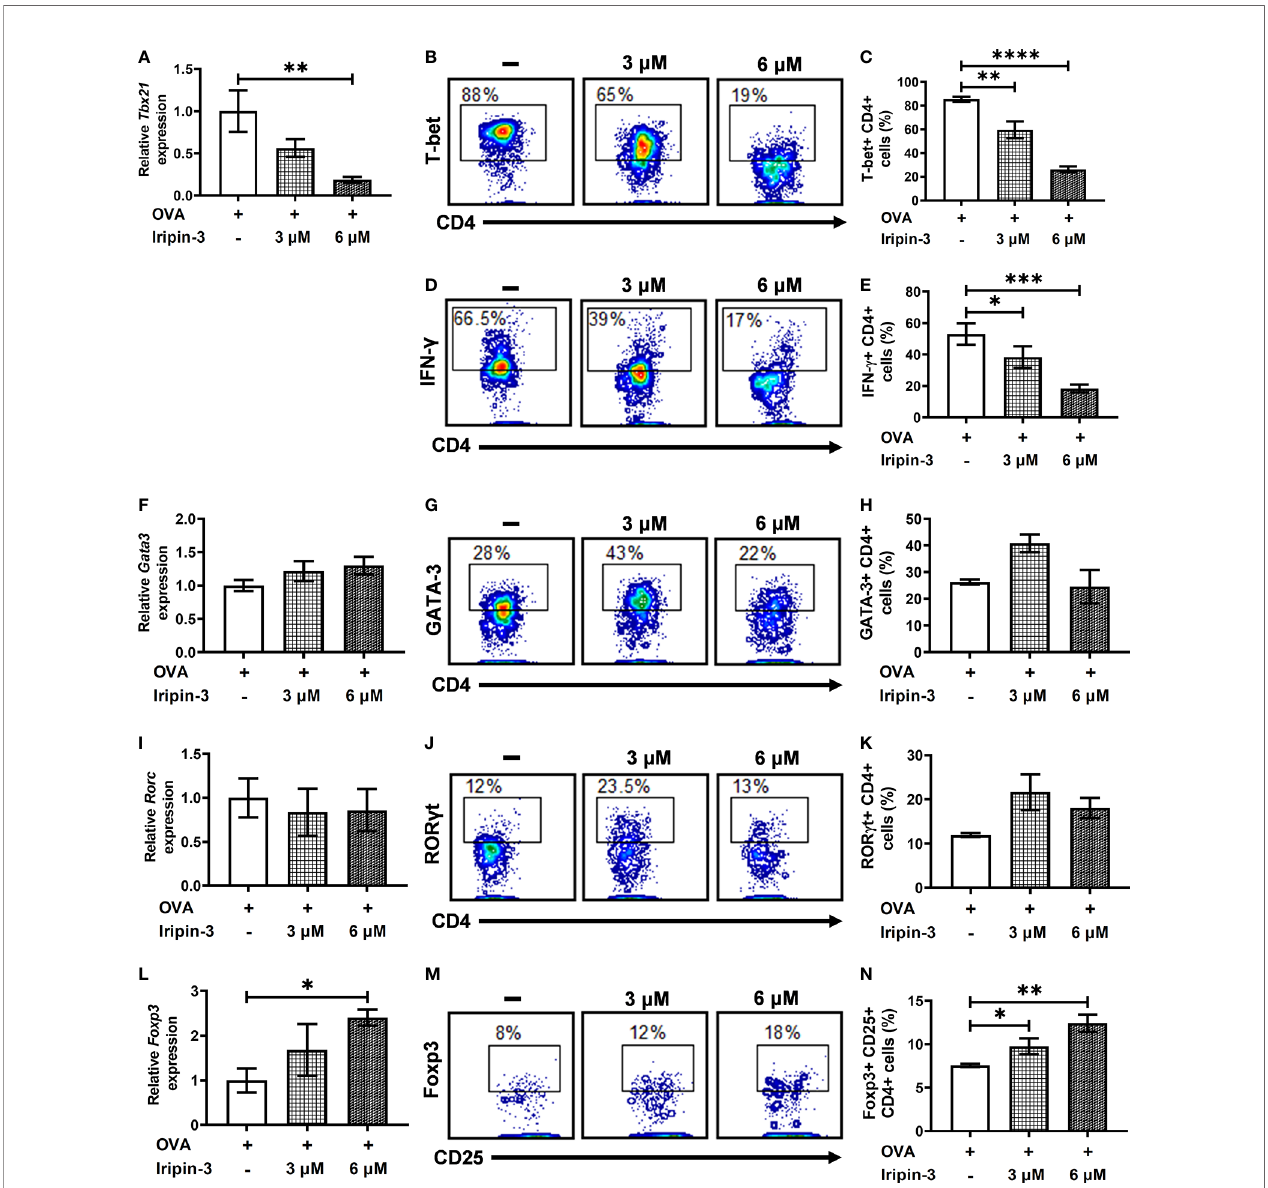
FIGURE 10 | Iripin-3 alters the expression of CD4 + T cell transcription factors at both the mRNA and protein levels. (A, F, I, L) Expression of Tbx21 (A) , Gata3 (F) , Rorc (I) , and Foxp3 (L) in CD4 + cells stimulated with OVA peptide for 72 h. Cells were untreated with Iripin-3 or were treated with 3 m M or 6 m M Iripin-3. Cells incubated only in the presence of OVA peptide were utilized as a calibrator during calculations of relative expression values. Data are presented as mean ± SEM of four independent experiments (* p < 0.05, ** p < 0.01). (B, D, G, J, M) Representative contour plots showing the proportion of OVA peptide-stimulated CD4 + splenocytes expressing T-bet (B) , IFN- g (D) , GATA-3 (G) , ROR g t (J) and the combination of CD25 and Foxp3 (M) . The cells were incubated in the absence of Iripin- 3 (left) or in the presence of two different Iripin-3 concentrations: 3 m M (middle) and 6 m M (right). (C, E, H, K, N) The percentage of CD4 + T cells producing the cytokine IFN- g (E) and expressing transcription factors T-bet (C) , GATA-3 (H) , ROR g t (K) , and Foxp3 together with CD25 (N) . Cells were cultured in the presence of Iripin-3 (3 m M or 6 m M) and OVA peptide for 72 h. Cells incubated without Iripin-3 were used as control. Data are presented as mean ± SEM of three